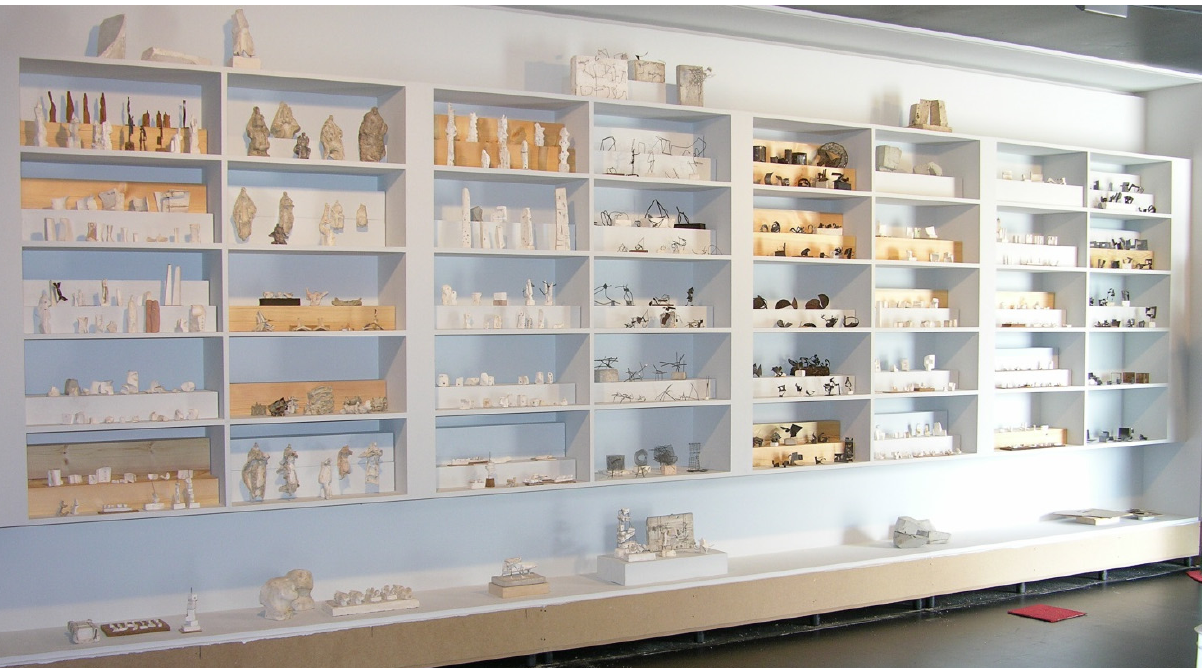
Figure 1. Collection of sculptures by Jorge Oteiza, Museo Fundación Jorge Oteiza, Navarra, Spain